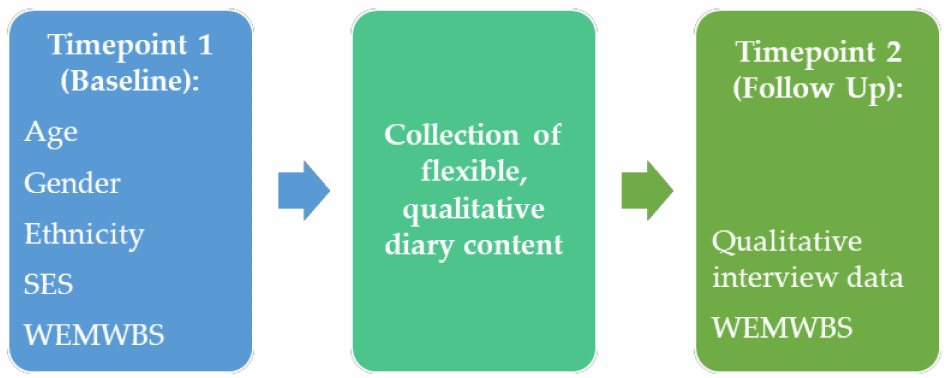
Figure 1. Type of data collected at each study